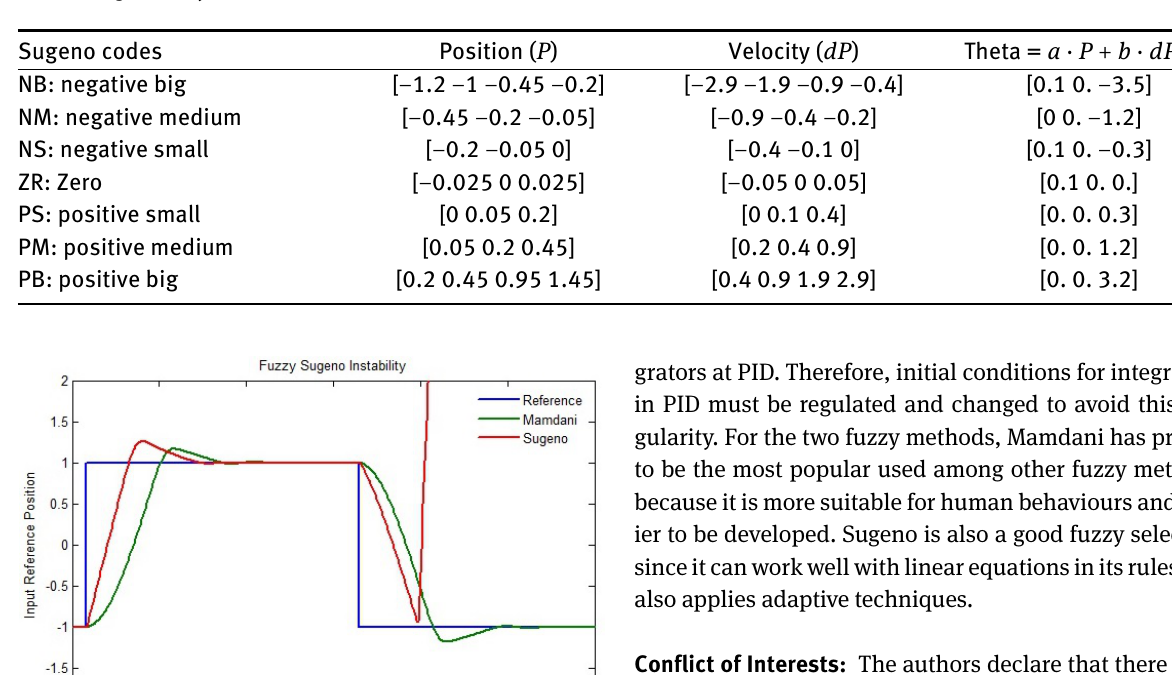
Table 2: Sugeno fuzzy rule values.